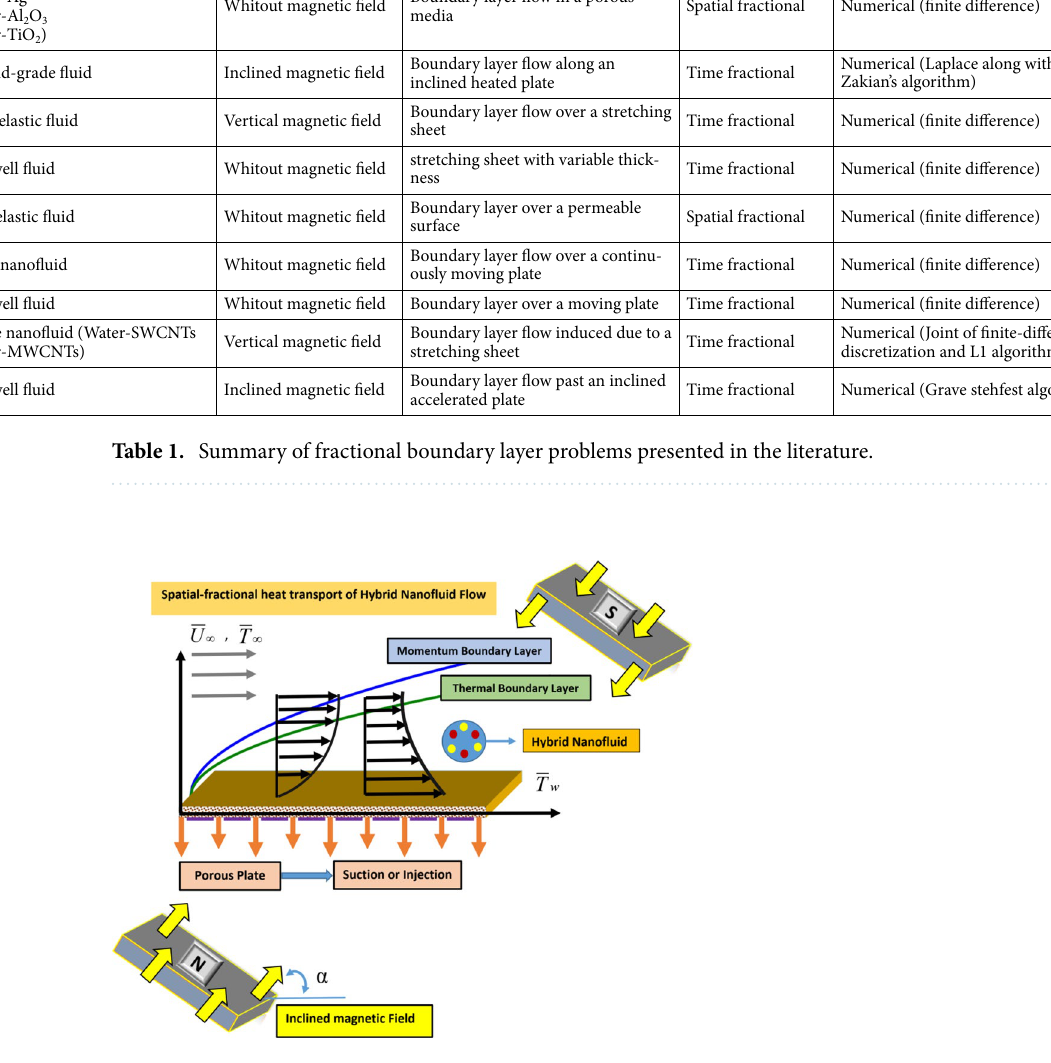
Figure 1. Geometry of the